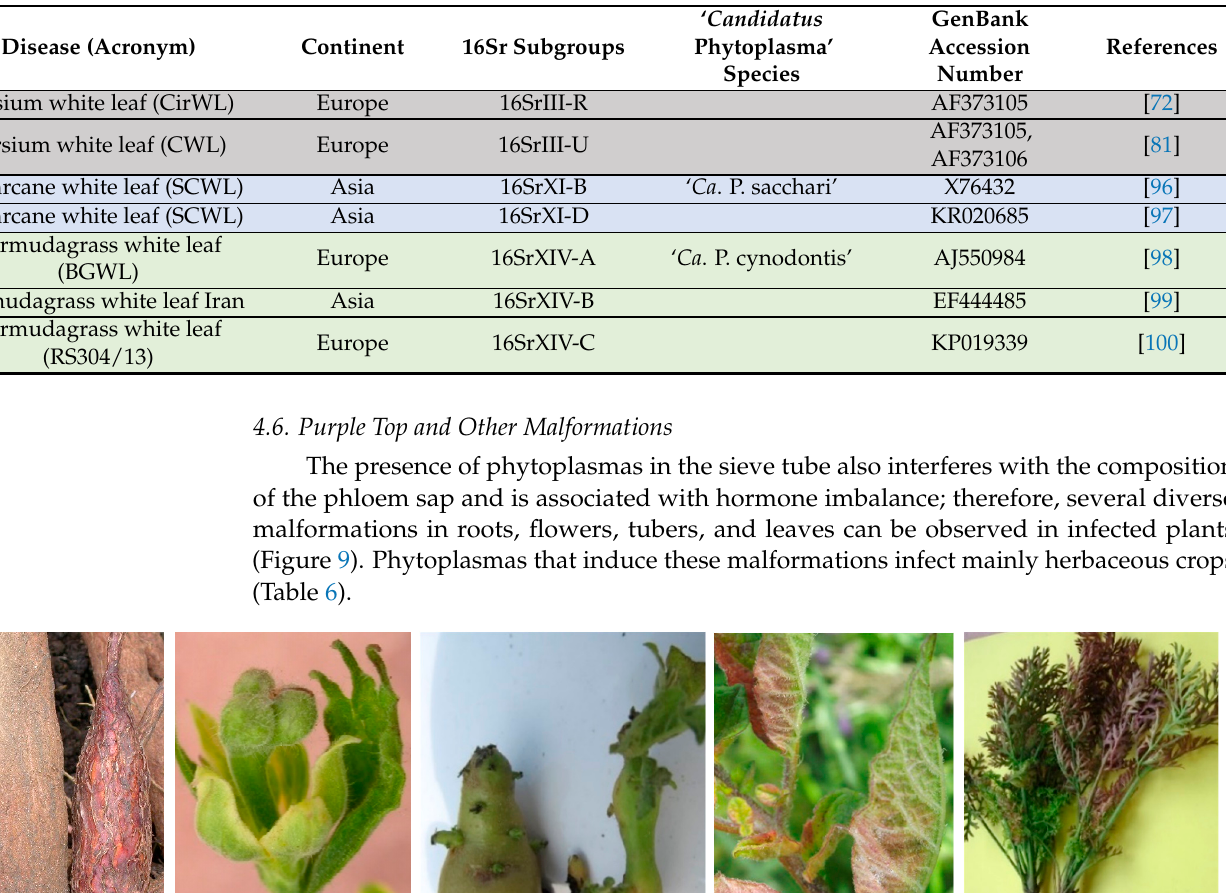
Figure 8. Bermudagrass white leaf in Cynodon dactilon ( a , b ) and yellow and stunting in tobacco ( c ). Table 5. Molecular diversity and geographic distribution of selected phytoplasmas belonging to different ribosomal groups/‘ Candidatus Phytoplasma’ species (marked by different color) associated with white leaf symptoms.